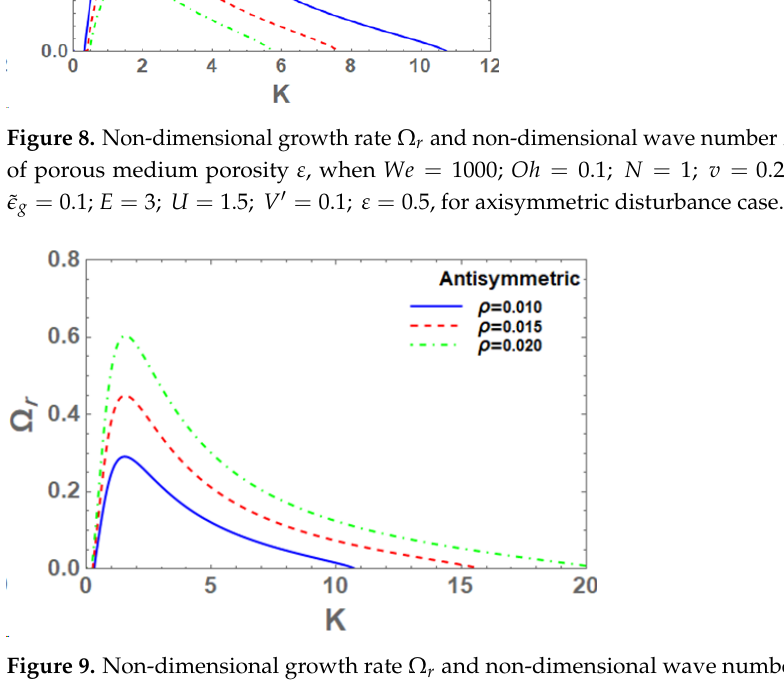
Figure 9. Non-dimensional growth rate Ω r and non-dimensional wave number K for different gas to liquid densities ρ , when We = 1000; Oh = 0.1; N = 1; ρ = 0.01; v = 0.2; κ 1 = 2; ˜ (cid:101) l = 0.3; ˜ (cid:101) g = 0.1; E = 3; V (cid:48) = 0.1; ε = 0.5, for axisymmetric disturbance case.